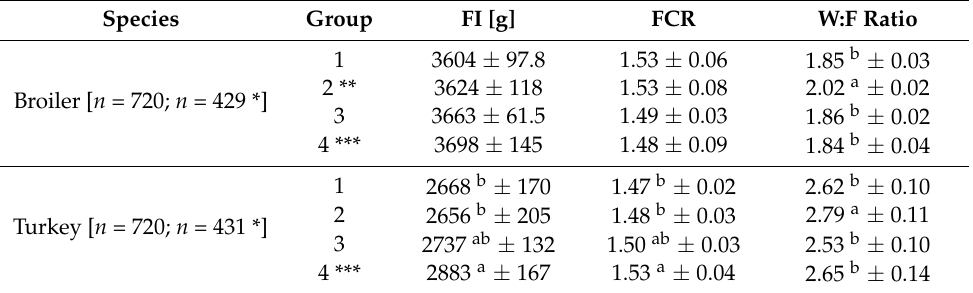
Table 3. Feed intake (FI), feed conversion ratio (FCR), and water to feed ratio (W:F ratio) during the